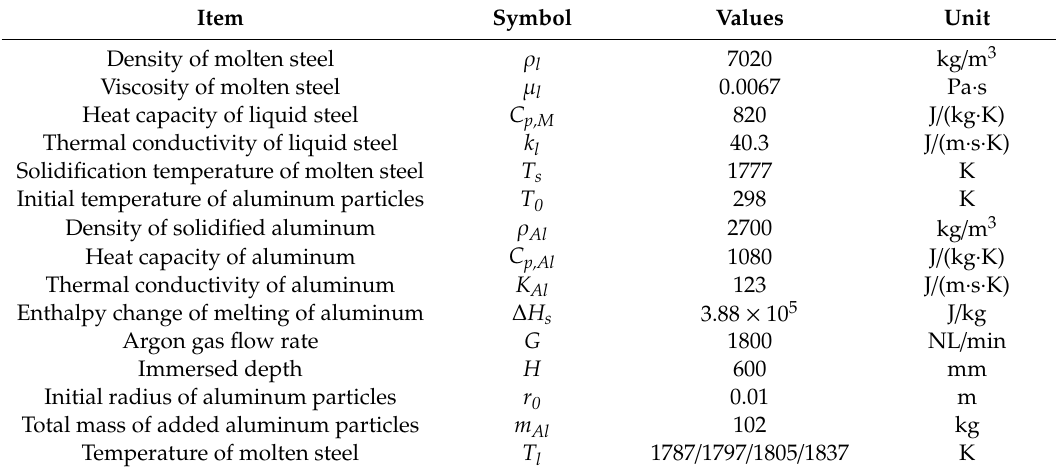
Table 1. Material properties and operation parameters (data from